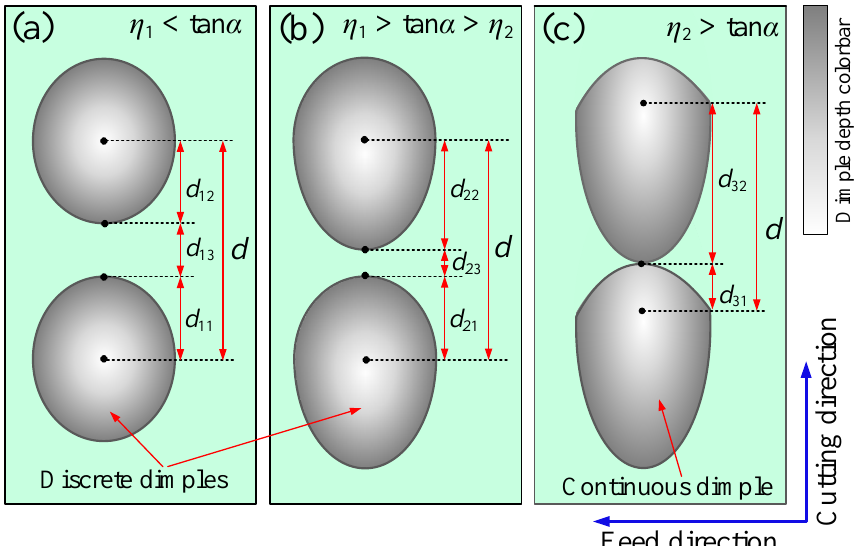
Figure 9. Illustration of dimple shape under different states. ( a ) η 1 < tan α ; ( b ) η 1 > tan α > η 2 ; ( c ) η 2 > tan α .